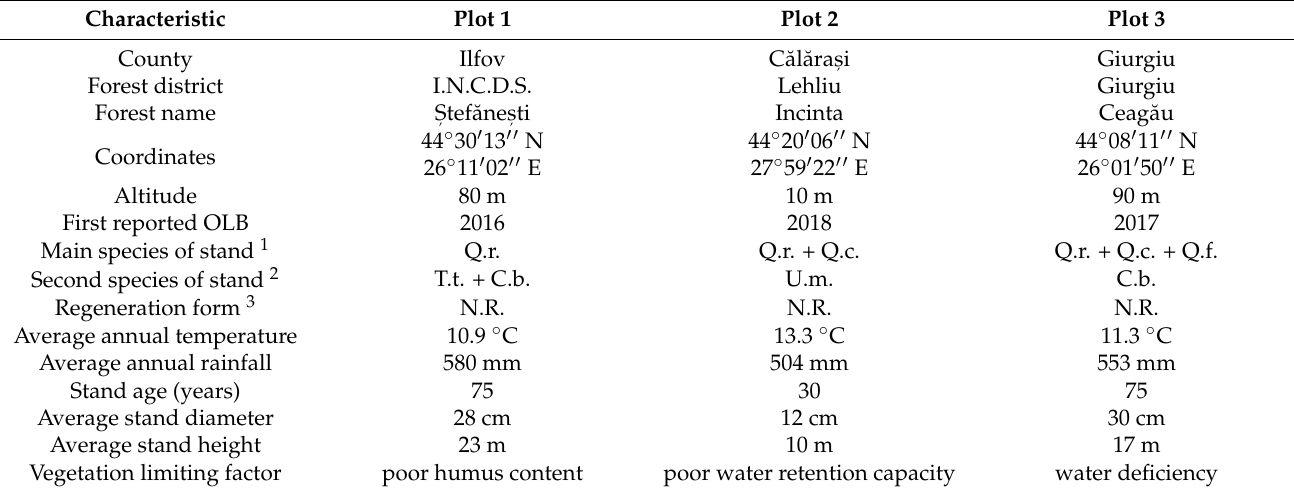
Table 1. Description of the three studied plots.